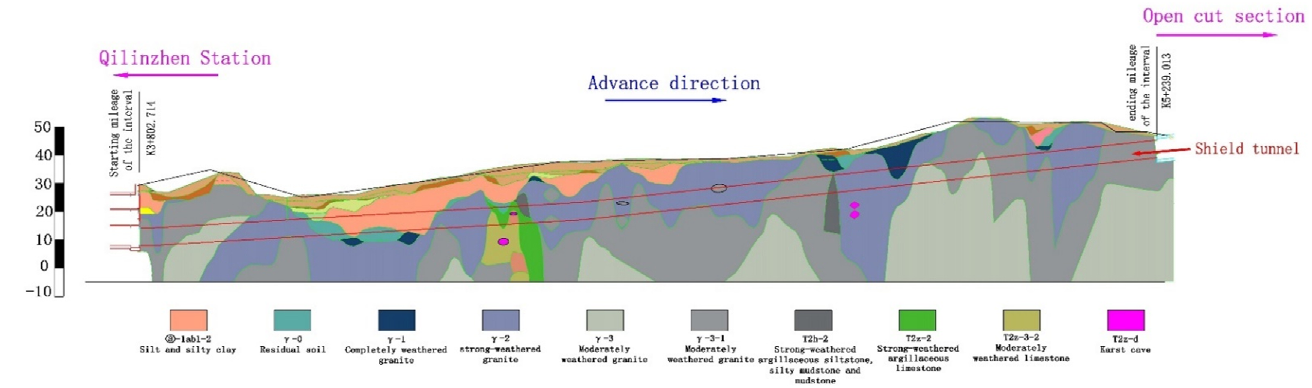
Figure 6. Geological profile of the tunnel between Qilin Town Station and Dongjiao Town Station.